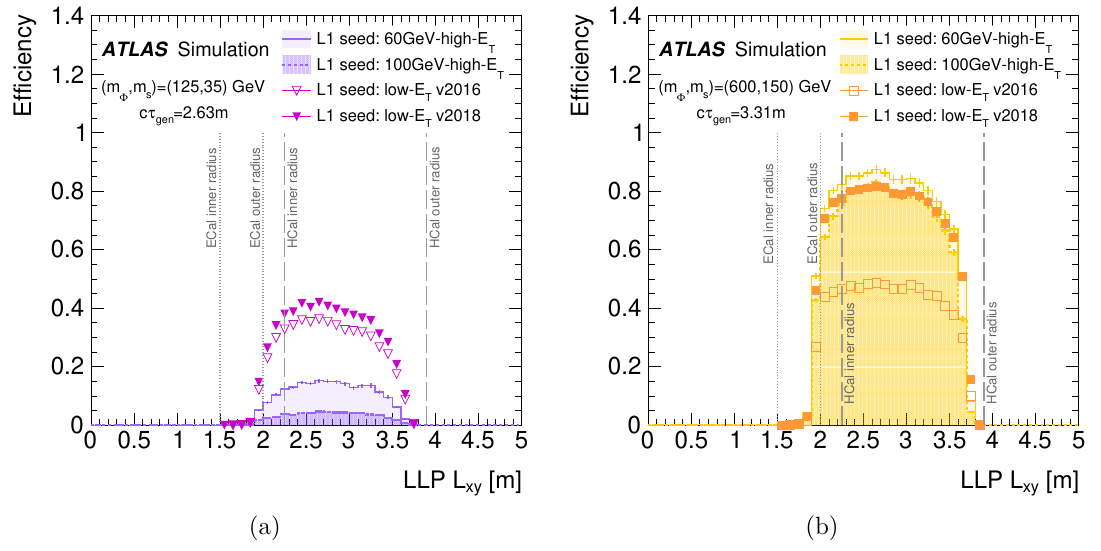
Figure 3. Trigger efficiency for simulated signal events as a function of the LLP decay position in the x – y plane ( L xy ) for LLPs decaying in the barrel ( | η | < 1 . 4 ) for (a) one of the low- E T signal samples and (b) one of the high- E T signal samples for HLT CalRatio triggers seeded by the high- E T L1 triggers with E T thresholds of 60 GeV and 100 GeV and by the two versions of the low- E T L1 triggers. Only statistical uncertainties are